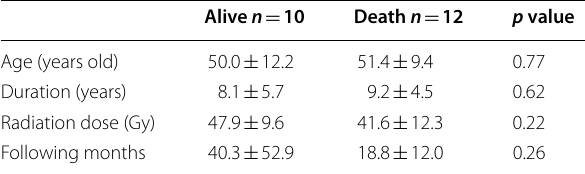
Table 3 Comparison with cases of dead and alive cases by t